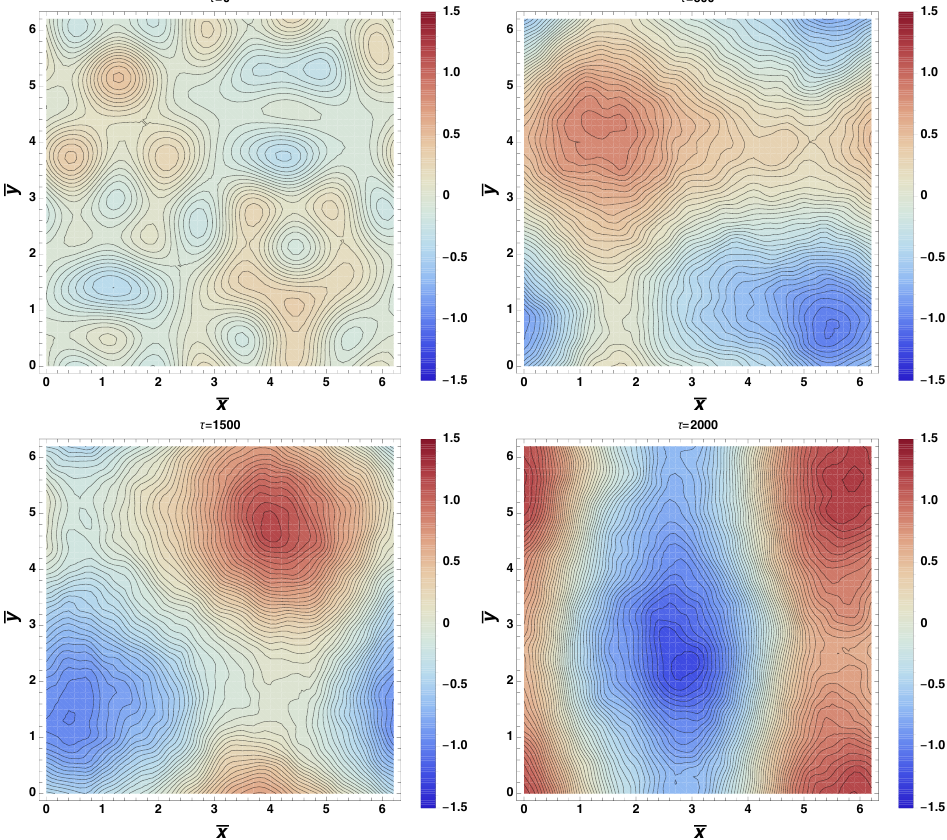
Figure 9. Case A2—inviscid. Contour plots of Φ ( ¯ x , ¯ y ) (in arbitrary units) at fixed times as indicated over the graphs. The potential Φ is built by inverting the Fourier